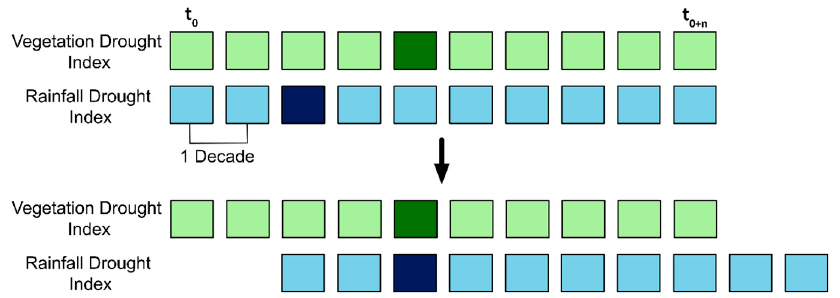
Figure 3. Analysis and exploitation of the time lag relationship. Every square represents a measurement for one decade. In this example, shifting the time series of the rainfall individual index two time steps to the right results in the highest correlation with the individual index representing the vegetation status (dark green and dark blue squares). In combination with the ability of one dataset to “predict” the vegetation status, the quality of the correlation defines the weight of the ECDI’s precipitation component in the overall index.